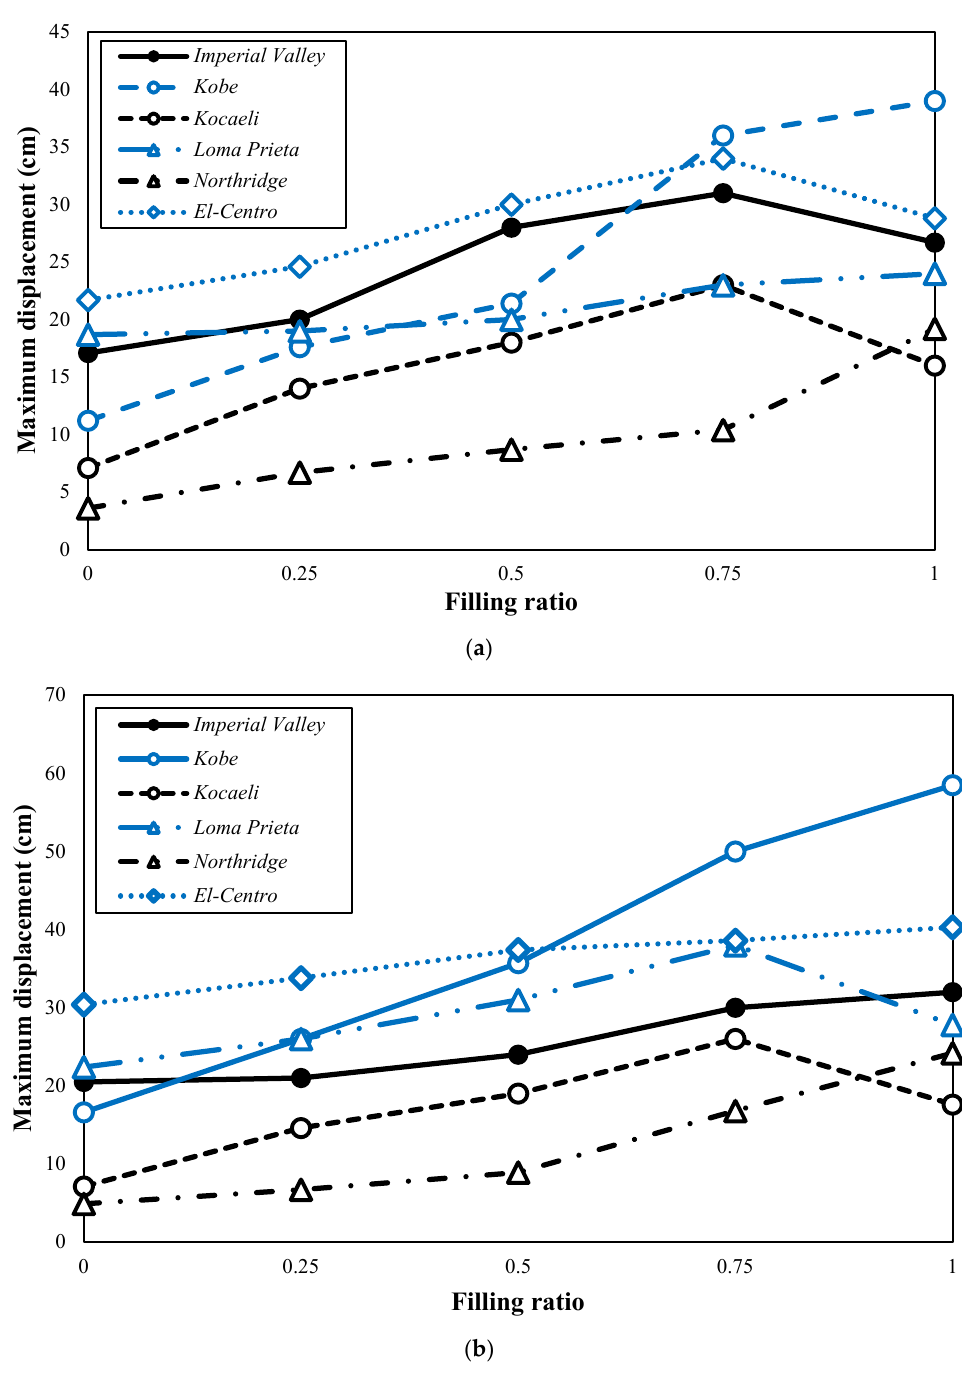
Figure 16. Differences in maximum displacement based on the filling ratio for ( a ) far ‐ fault ground motions and ( b ) near ‐ fault ground motions .